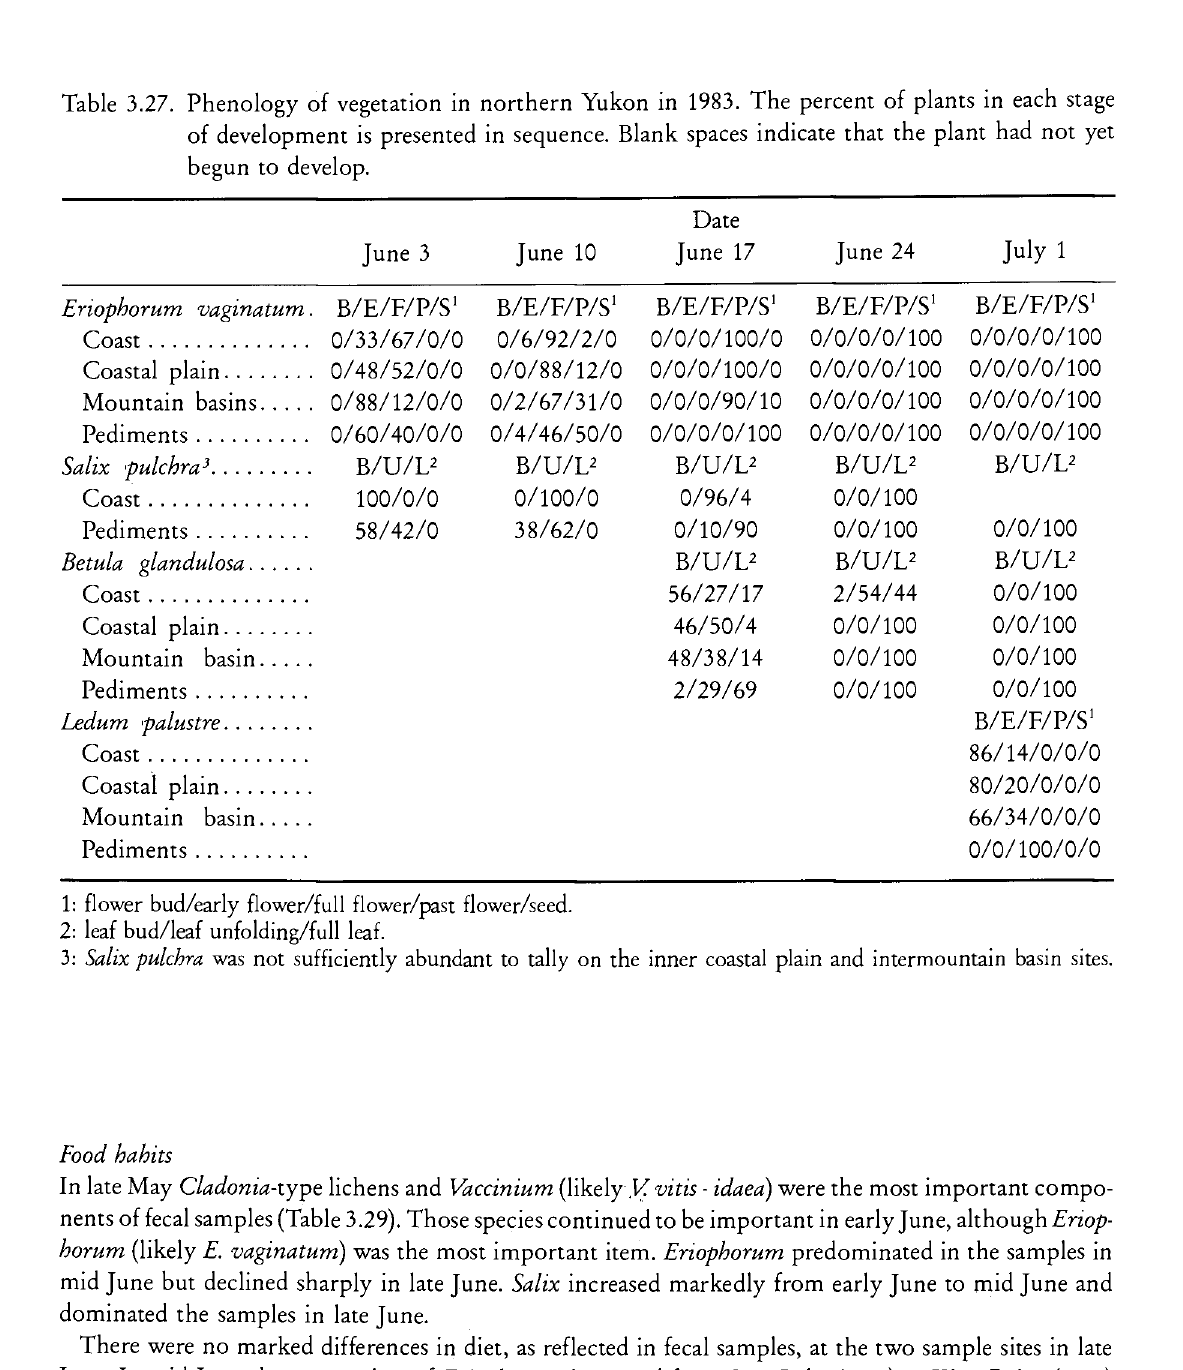
Table 3.27. Phenology of vegetation in northern Yukon in 1983. The percent of plants in each stage of development is presented in sequence. Blank spaces indicate that the plant had not yet begun to